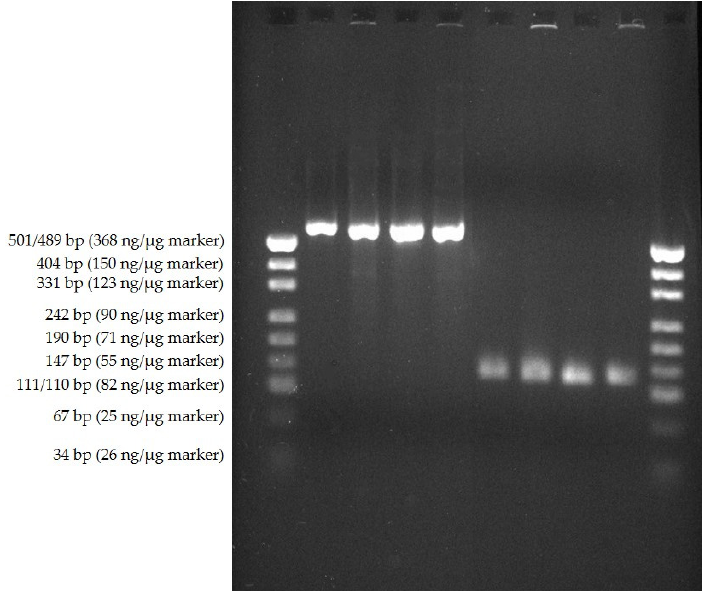
Figure 2. Agarose gel electrophoresis of colony PCR: slots 1 and 10: marker; slots 2–5: colony PCR products of PCR-no. 1 (Table 2) of different picked colonies, amplifying V1, V2 and V3 of the 16S rRNA-gene; slots 6–9: colony PCR products of PCR-no. 2 (Table 2) of different picked colonies, amplifying V6 of the 16S rRNA-gene.